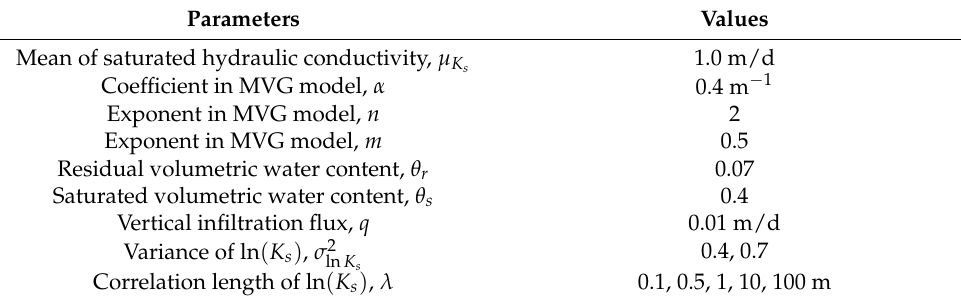
Figure 2. The hypothetic slope in the numerical study. Table 1. Soil hydraulic parameters used in the study.